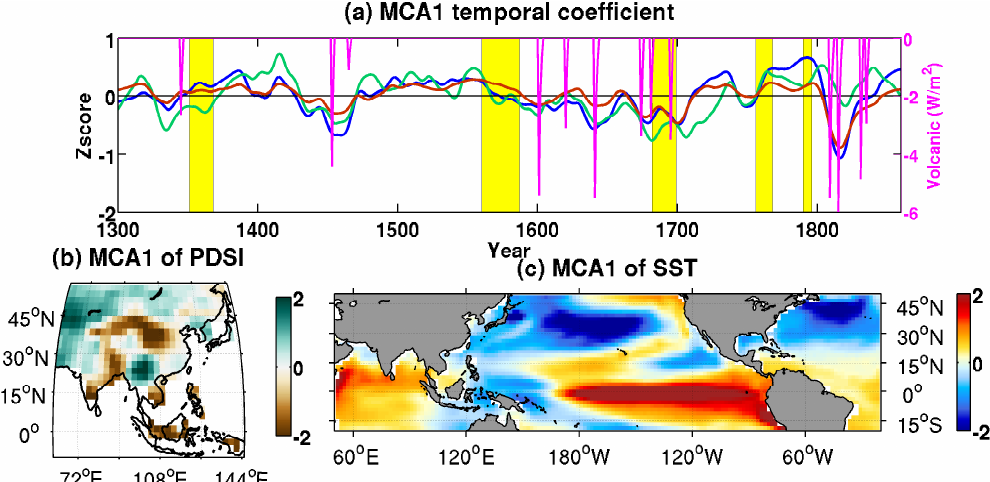
Figure 5. MCA results for GISS-E2-R: (a) time series for PDSI (green line), SSTA (blue line), volcanic forcing (magenta) and 2 × Niño 4 (red line). The five recorded mega-drought periods are shaded in yellow. (b) MCA1 pattern for PDSI. (c) MCA1 pattern for